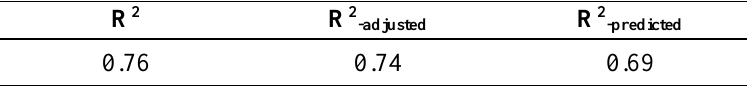
Table 2. Summary of the conducted regression